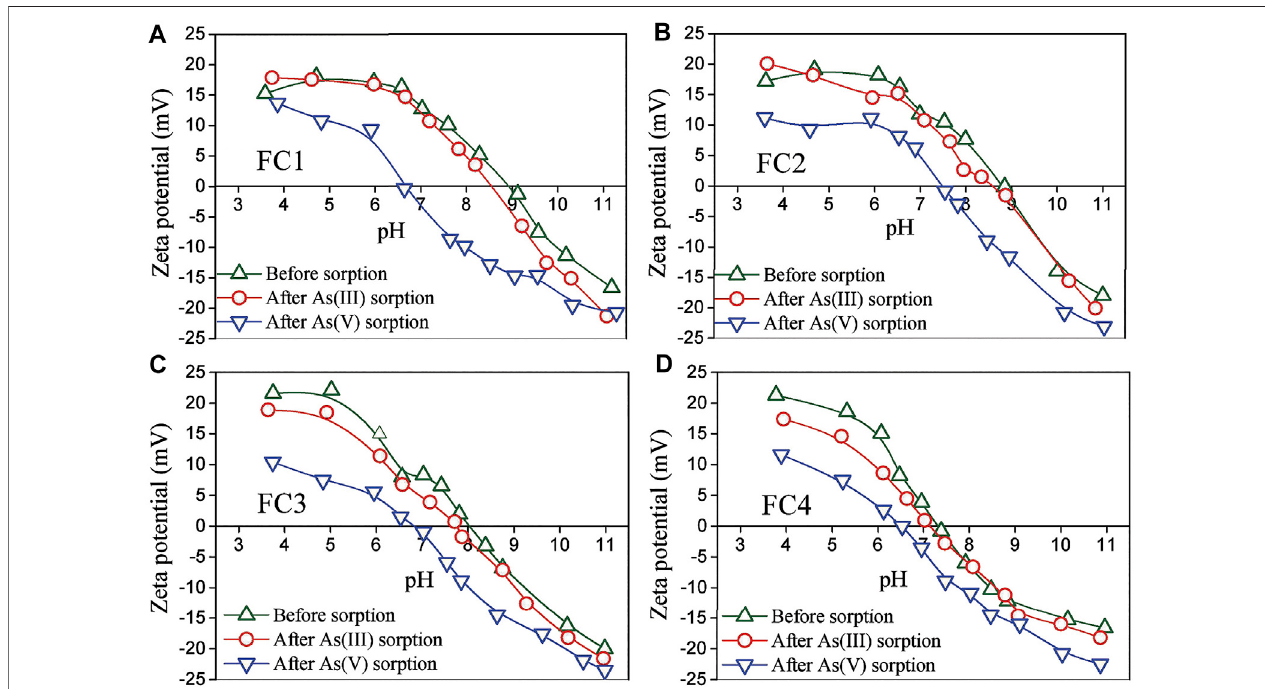
FIGURE 7 | Zeta potential of Fe-Cu binary oxides before and after arsenic adsorption. Initial arsenic concentration (cid:2) 10 mg/L, adsorbent dose (cid:2) 200 mg/L, ionic strength (cid:2) 0.01 M NaNO 3, equilibrium time (cid:2) 72 h.